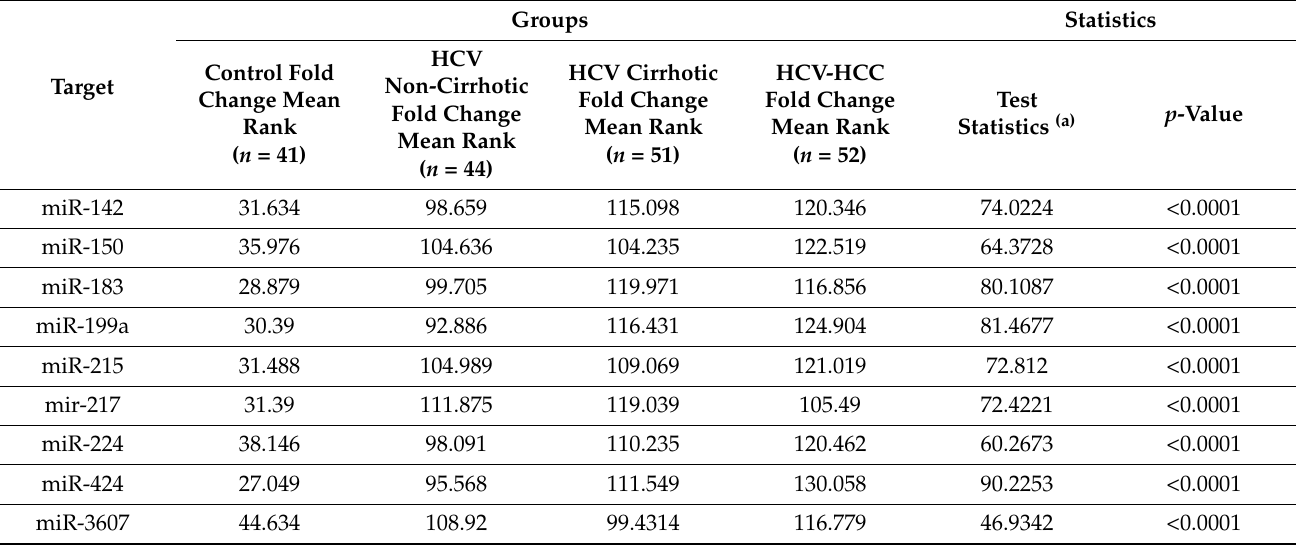
Table 5. Fold change mean rank of target miRNAs among the studied